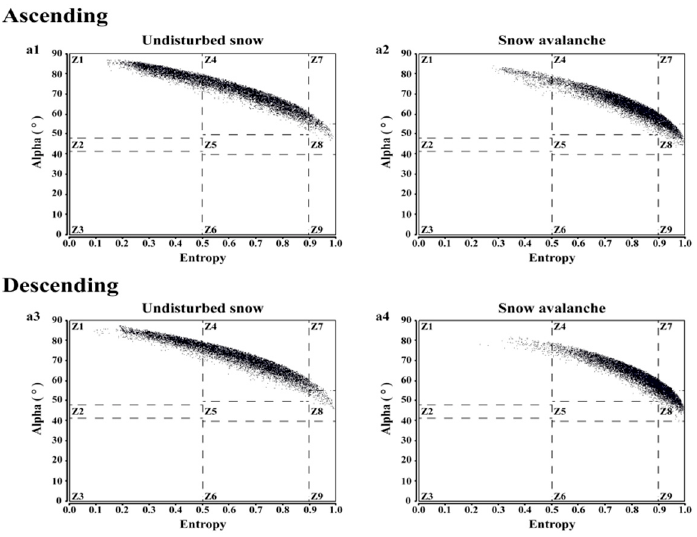
Figure 6. H- α space segmentation plot.